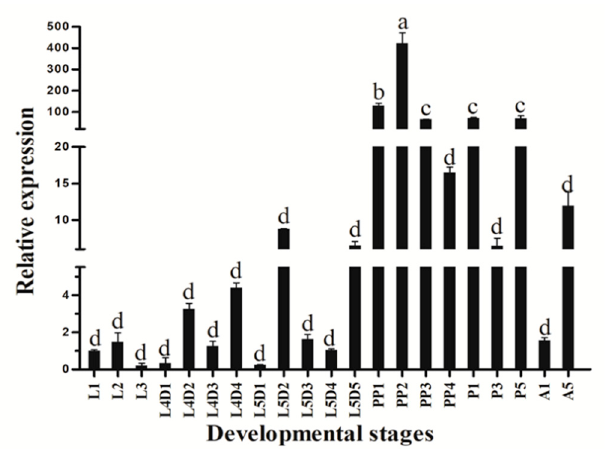
Figure 2. Relative expression levels of HvATG8 at different stages: L1–L3, first- to third-instar larvae; L4D1–L4D4, 1-day-old fourth-instar larvae to 4-day-old fourth-instar larvae; L5D1–L5D5, 1-day-old fifth-instar larvae to 5-day-old fifth-instar larvae; PP1–PP4, 1-day-old to 4-day-old prepupae; P1, 1-day-old pupae; P3, 3-day-old pupae; P5, 5-day-old pupae; A1, 1-day-old adults; and A5, 5-day-old adults. Its expression levels at each developmental stage were normalized relative to that at L1. Error bars represent mean ± standard error of three biological replicates. Different letters above error bars indicate significant differences ( p <0.05) based on one-way analysis of variance and Tukey’s test.